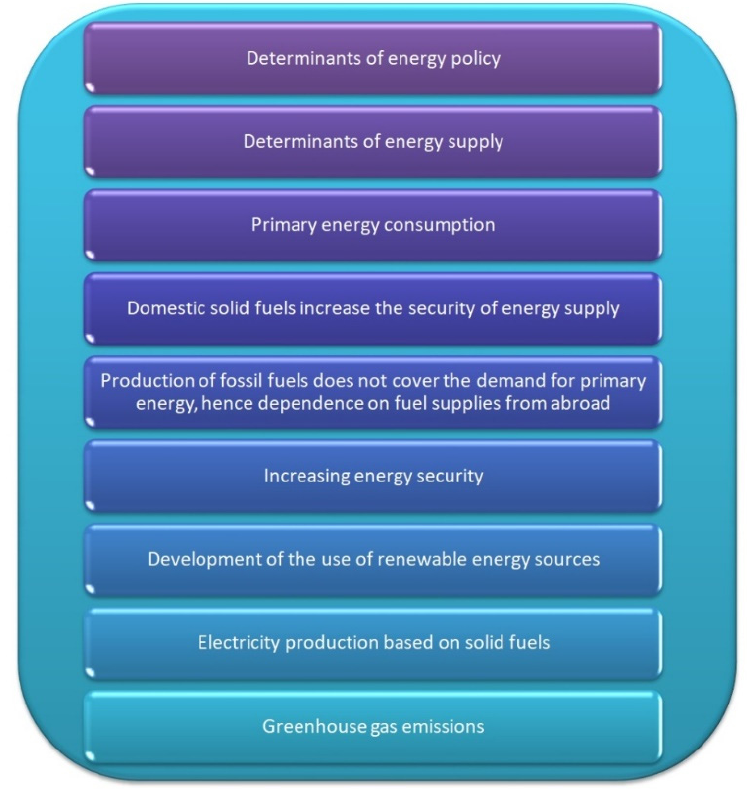
Figure 1. Determinants of the energy policies of Poland and Germany [16].